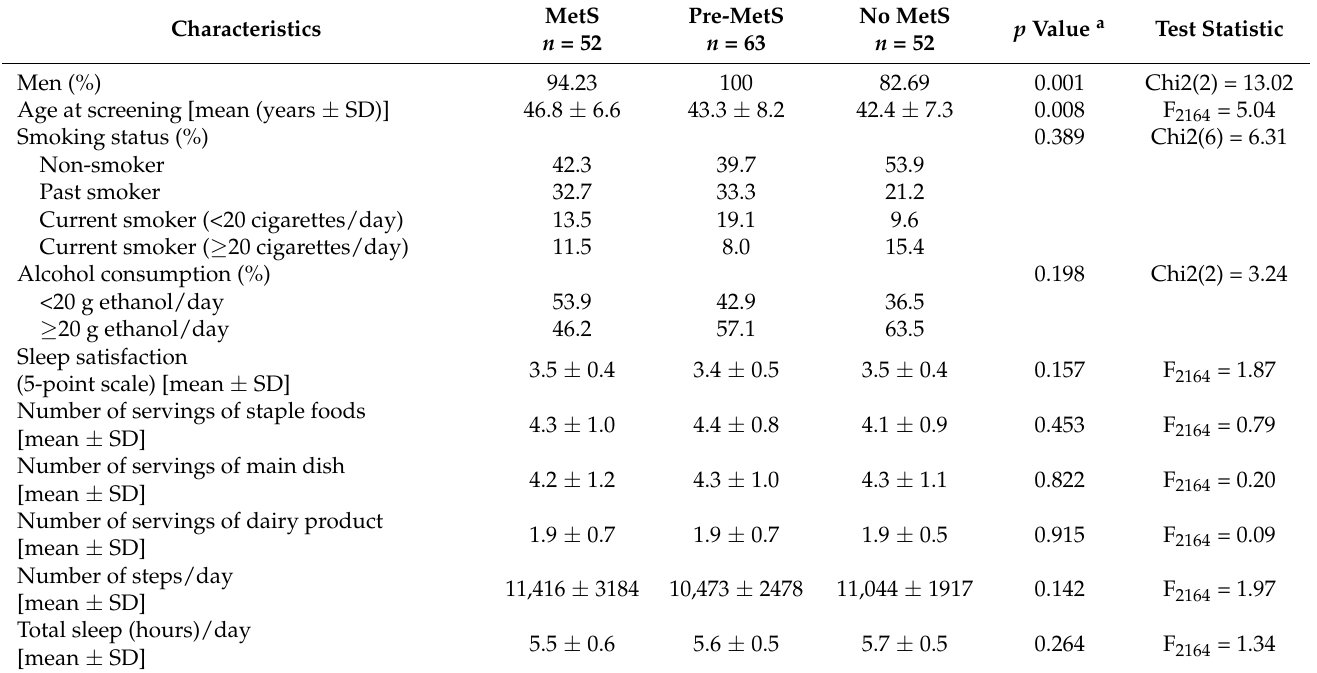
Table 1. Baseline characteristics according to the classification of metabolic